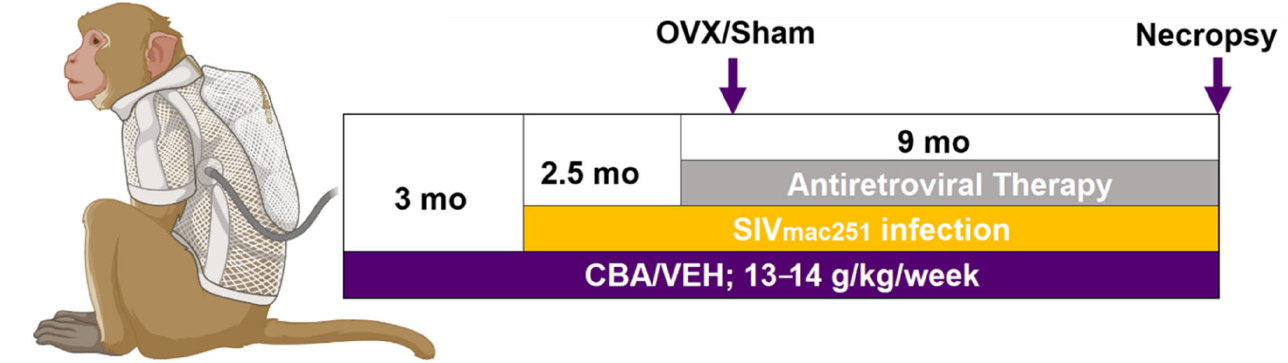
Figure 1. Macaque study design. Adult (6–9 year old) female Indian rhesus macaques ( Macaca mulatta ) were administered chronic binge alcohol (CBA) at a concentration of 30% (wt/vol) in water (30 min infusion; 5 days/wk; 12–15 g/kg/wk) intragastrically or isovolumetric water (vehicle; VEH). After 3 months of CBA/VEH administration (pre-simian immunodeficiency virus (SIV)), all animals were infected intravaginally with SIV mac251 . CBA/VEH administration continued throughout the study. At viral set-point (2.5 mo post-SIV infection), all macaques were initiated on antiretroviral therapy (ART). One month post-initiation of ART, animals were randomized for either ovariectomy (OVX) or SHAM surgeries and humanely euthanized at 8 months following OVX or SHAM (Necropsy). The total time for CBA/VEH administration was 14.5 months, SIV infection 11.5 months, and ART 9 months. Samples from necropsy were used for this study.